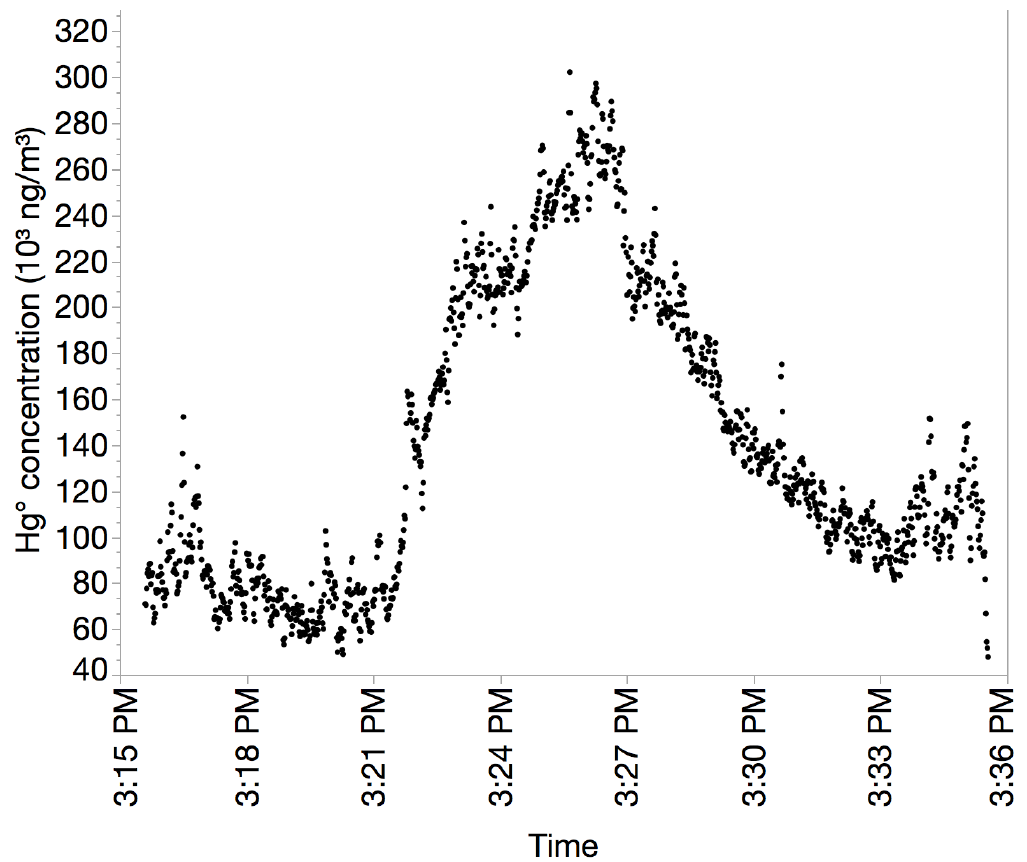
Figure 6. Hg 0 concentrations recorded at a gold shop in Bartica, Guyana.